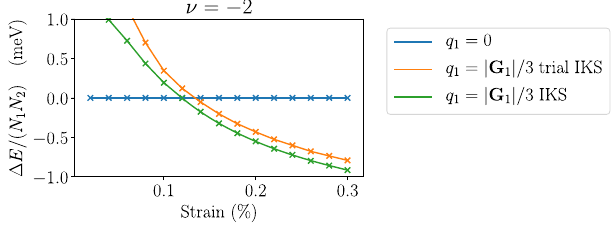
FIG. 7. Comparison of the energies of the translationally invariant state, the IKS state, and the IKS trial state at ν ¼ − 2 . The IKS trial state is obtained by taking two copies of the IKS HF solution at ν ¼ − 3 . System size is 12 × 12 , Δ ¼ 0 meV, and NLT is